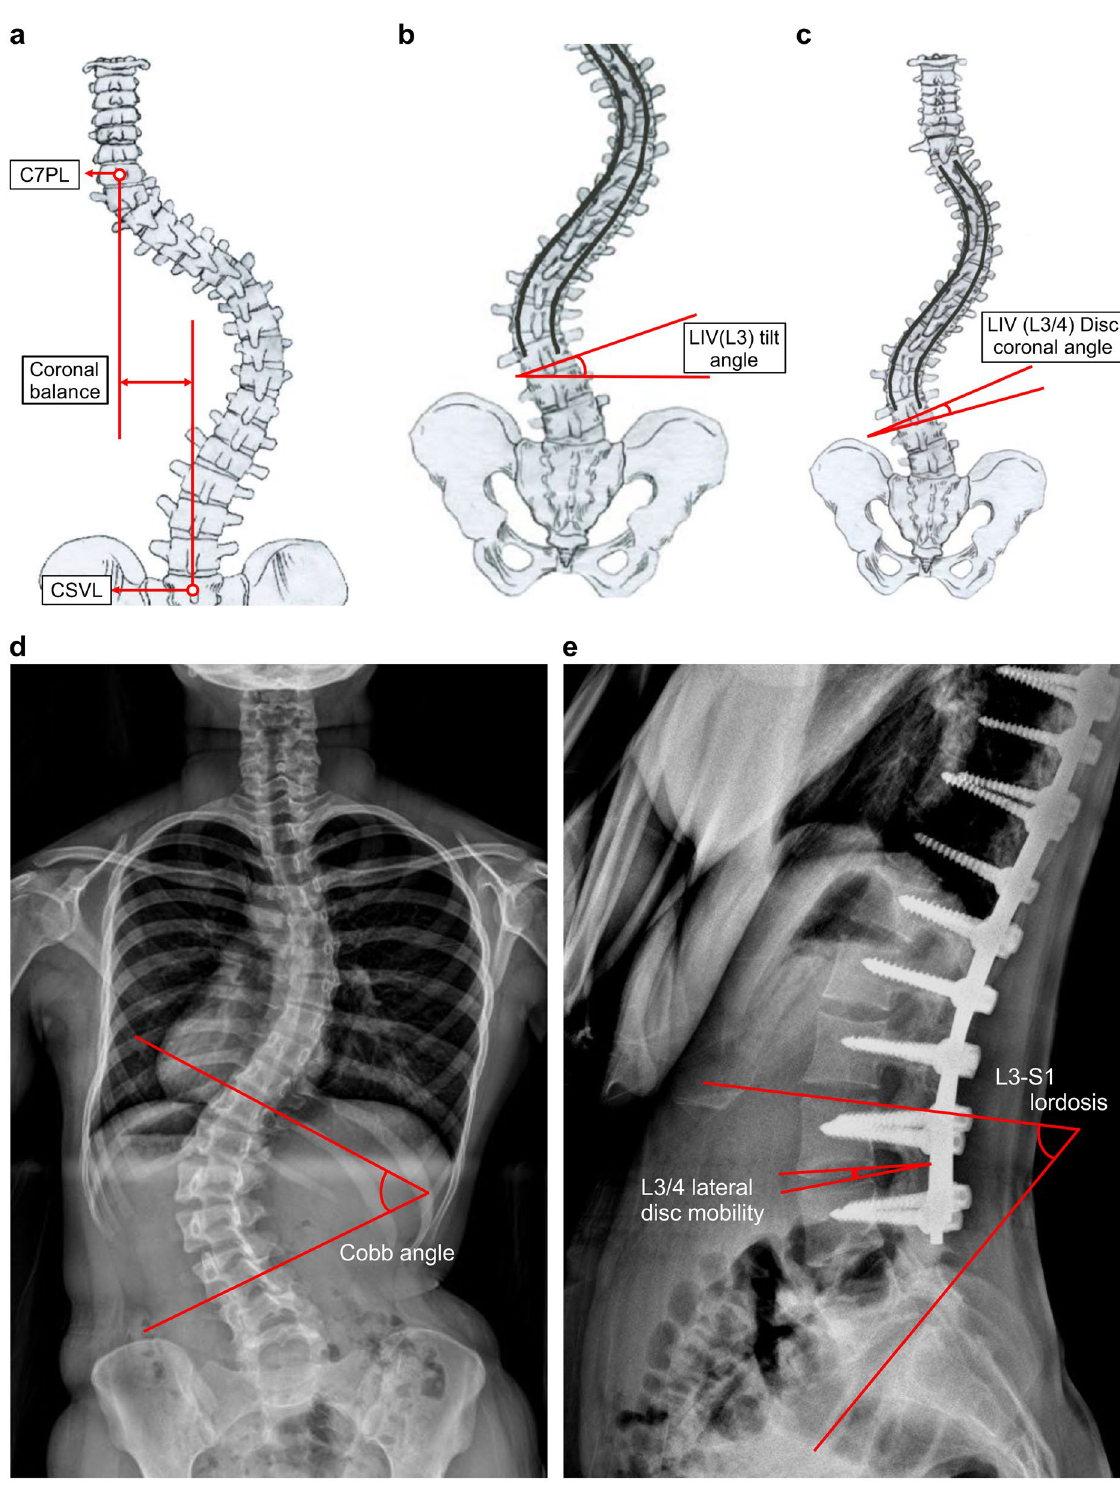
Figure 2. Radiographic parameters measured in the standing whole spine PA, lateral images, and full flexion– extension dynamogram of lumbar spine ( a ) Coronal balance is the distance (mm) between the coronal C7 plumb line and the CSVL. ( b ) The LIV (L3) tilting angle is the angle between the line measured on the inferior endplate of L3 and the horizontal line. ( c ) The LIV (L3/4) disc coronal angle was measured from lines between the L3 lower endplate and the L4 upper endplate. ( d ) The Cobb angle is the angle between the upper and lower end vertebra. ( e ) L3-S1 lordosis is indicated as the line measured on the superior endplate of the L3 and S1 regions. The L3/4 lateral disc mobility is the angle range of the L3/4 disc in full flexion–extension